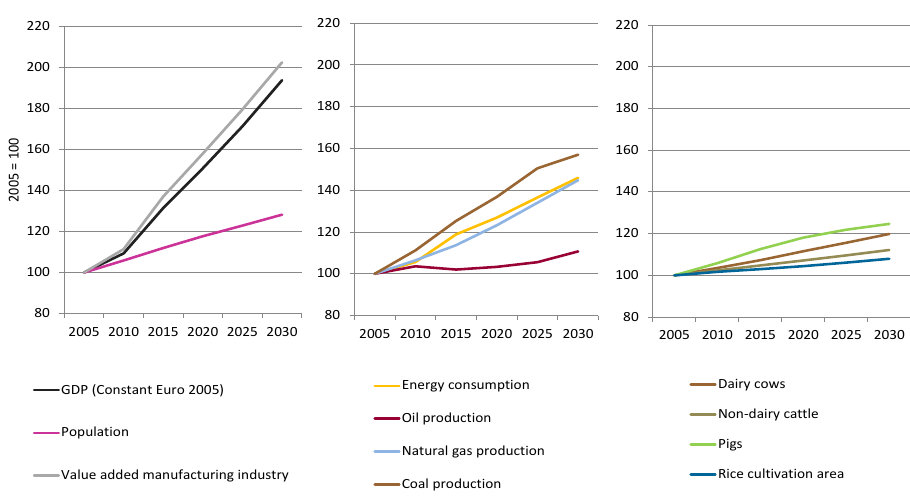
Fig. 1. Global development 2005 to 2030 in major drivers for CH 4 emissions entering model estimations from external sources (IEA-WEO, 2009; FAO, 2003; CAPRI model, 2009).